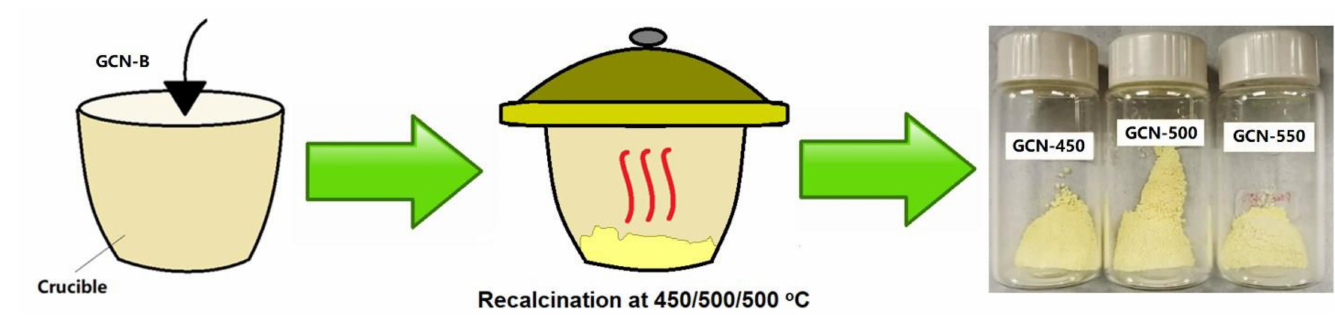
Figure 2. Schematic flow of the highly mesoporous GCN